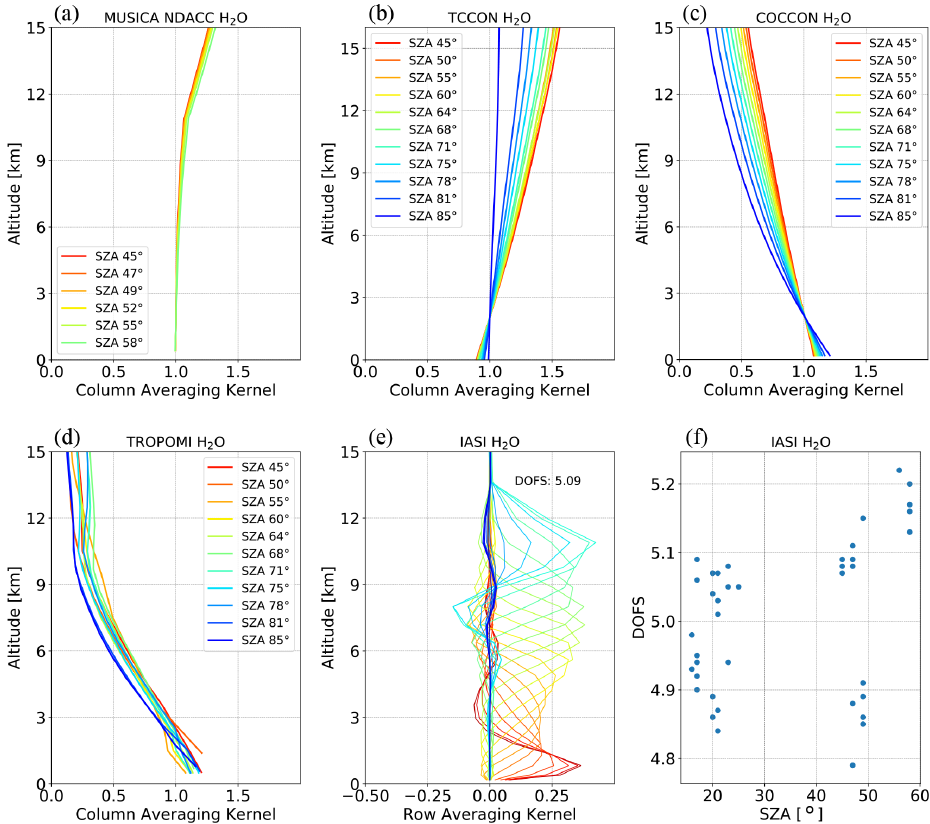
Figure 5. Examples of column averaging kernels for H 2 O from (a) MUSICA NDACC, (b) TCCON, (c) COCCON, and (d) TROPOMI for different SZAs; (e) examples of row averaging kernels from IASI at DOFS = 5 . 09; and (f) the correlation between SZAs and DOFS for IASI on 2 July